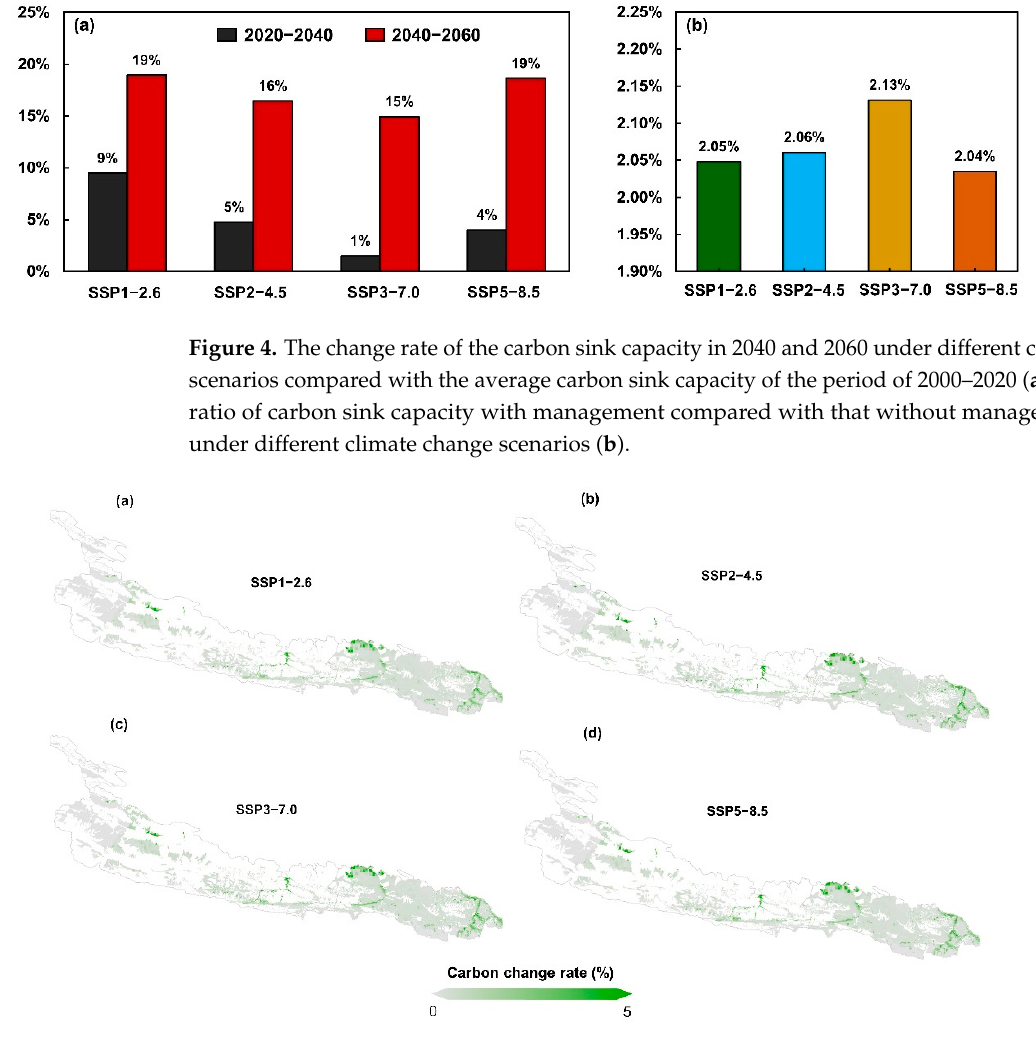
Figure 5. The distribution of the change rate of the carbon sink capacity with and without manage- ment in 2060 under climate change scenarios SSP1-2.6 ( a ); SSP2-4.5 ( b ); SSP3-7.0 ( c ) and SSP5-8.5 ( d ).